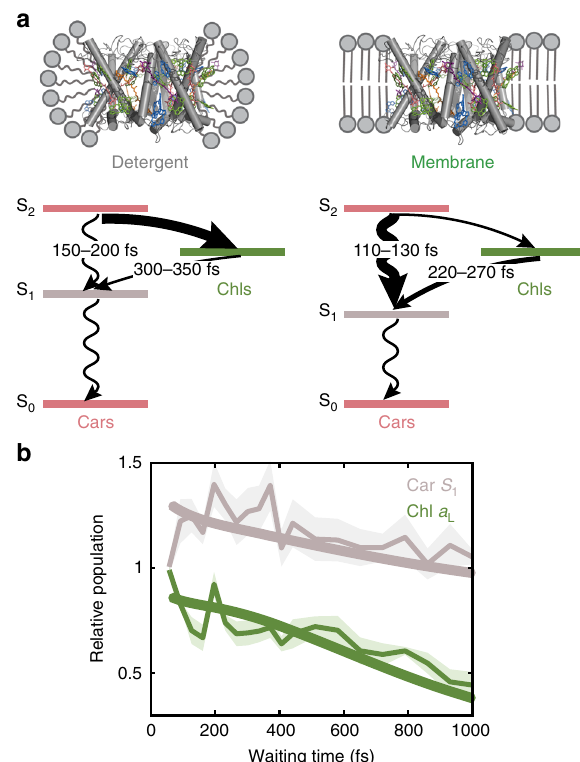
Fig. 4 Impact of the membrane on the photophysics and proposed kinetic model. a Schematic illustration of the alteration of LHCII photophysics by the membrane environment. The cartoons and energy level diagrams (not to scale) illustrate the quenched subpopulation of LHCII embedded in the detergent (left) and membrane (right) environment, respectively. Curved arrows illustrate energy transfer between Cars and Chls, and squiggly arrows illustrate non-radiative decay pathways of the Cars. The thickness of the arrows qualitatively shows the relative ef fi ciency of the corresponding pathway. b Relative population of the low-energy Chl a locus (green) and Car S 1 (gray) for the membrane relative to detergent. Thick curves are obtained from the kinetic model (Supplementary Note 8), and thin curves show the peak ratio of the Chl a L diagonal and Car S 1 ESA peaks from the 2D data with error bars (shaded regions, s.d. from three independent measurements). The population of the Car S 1 is enhanced in the membrane and the population of the Chl a L is